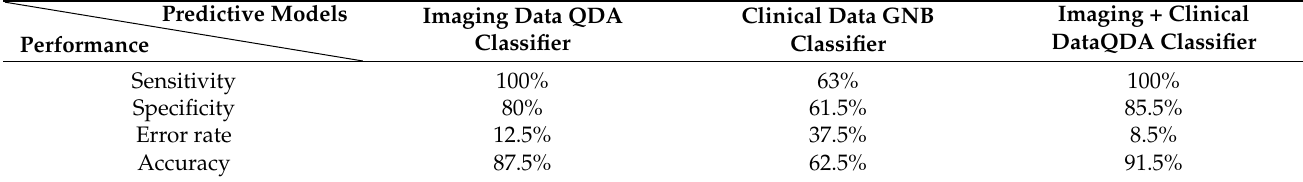
Table 4. Performance metrics of the different predictive models. Only metrics for the classifier providing the best results for each of the models are